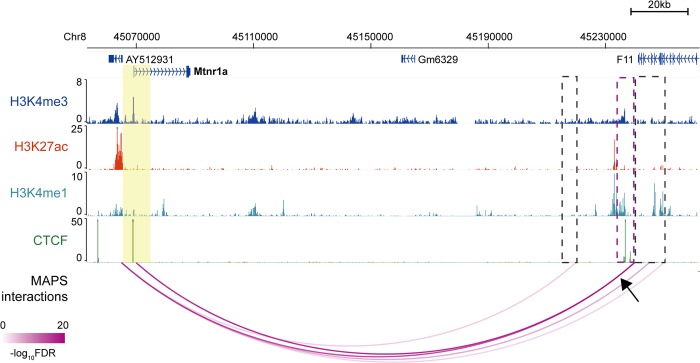
Genome-browser shows MAPS-identified interactions anchored at Mtnr1a promoter from mESC H3K4me3 PLAC-seq data.Anchor regions around Mtnr1a promoter are highlighted by yellow box (chr8:45,065,000–45,075,000, two 5Kb bins). The MAPS-identified interactions overlapping this anchor region are marked by magenta arcs. The black arrow points to the interaction verified in the previous publication [20] and the other end of the interaction is marked by magenta box. Additional interacting regions identified by MAPS are marked by grey boxes. No interaction is identified by hichipper anchored at this region from mESC H3K4me3 PLAC-seq data.